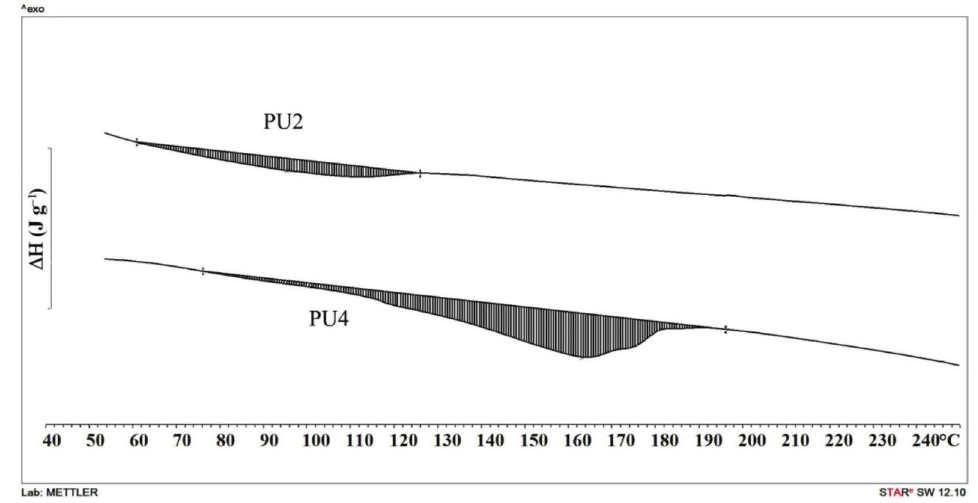
Fig. 2 – DSC heating curves of PU2 and PU4 elastomers before UV